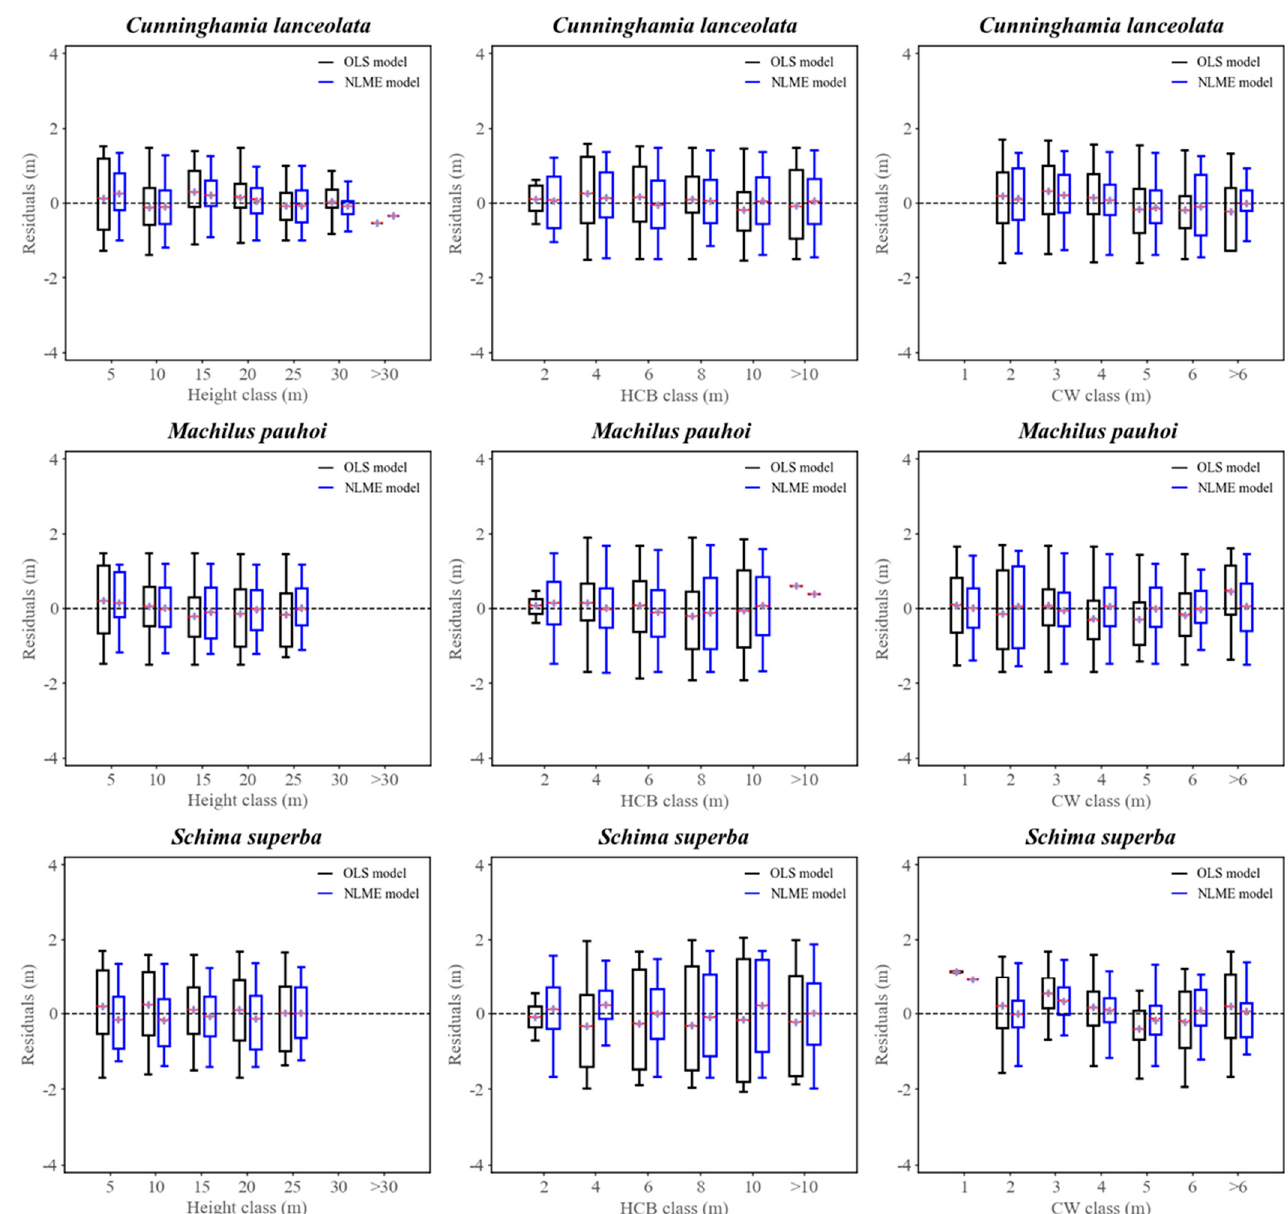
Figure 5. Box plots of standard residuals of three dominant tree morphological models. The box length, whisker length, horizontal lines in red, and plus signs in a box represent the interquartile range (IQR); the class minimum and maximum values in the IQR; and the class median and mean values, respectively. Cunninghamia lanceolata , Machilus pauhoi, and Schima superba are represented by SM, BHN, and MH, respectively.